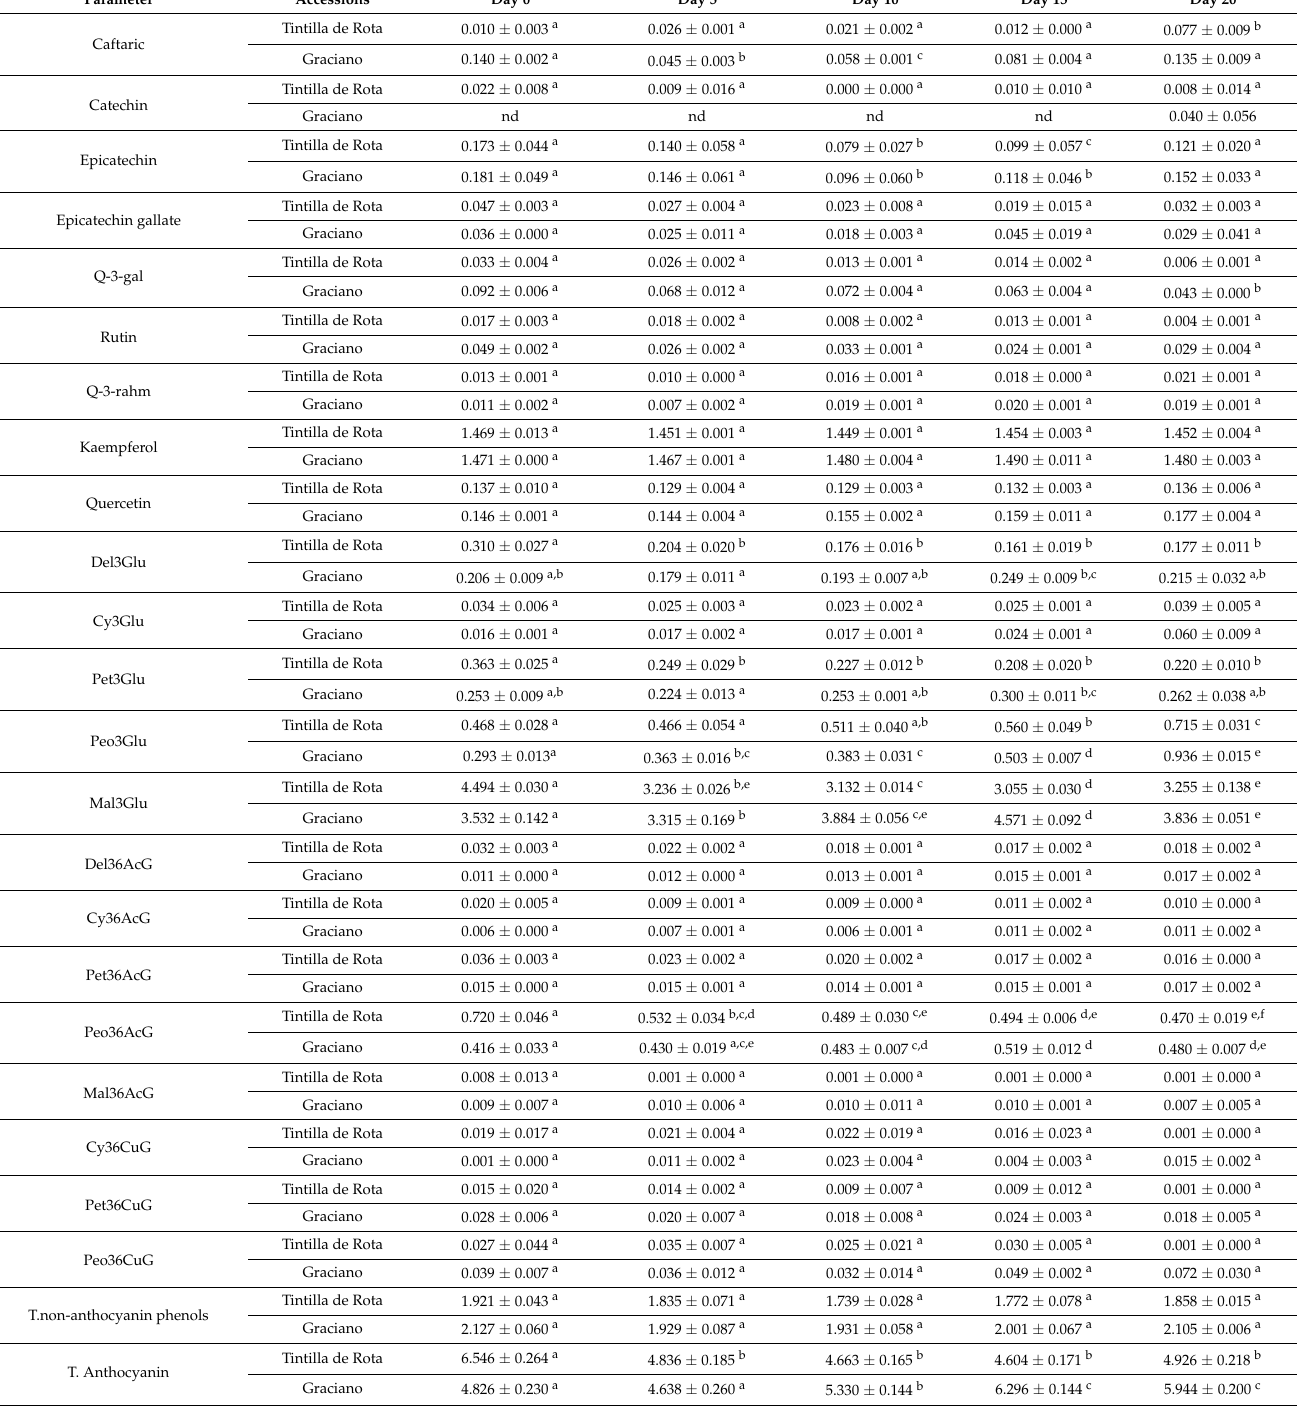
Table 2. Phenolic compound (mg/g dry weight) (including anthocyanins) development in Tintilla de Rota and Graciano accessions during the ripening